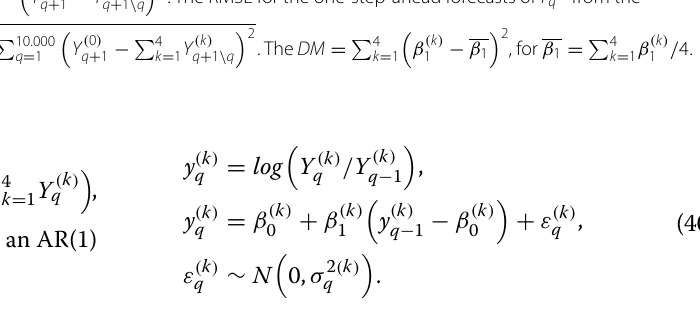
( 0 ) q from an 0 ) q from the